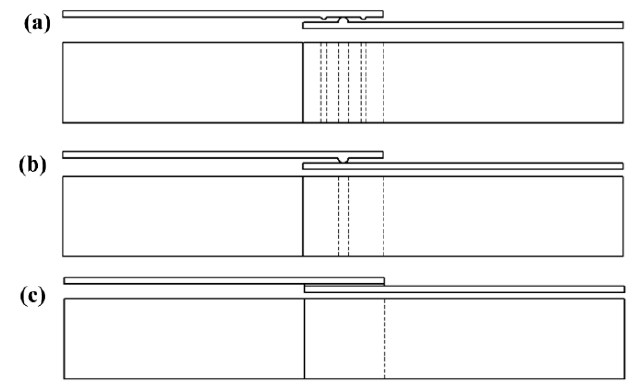
Figure 7. Schematic of welding configurations used ( a ) SC-ELC_2SC-ELC; ( b ) SC-ELC_FL-ELC; and, ( c ) FL-ELC_FL-ELC (ELF 0.5 mm and 0.25